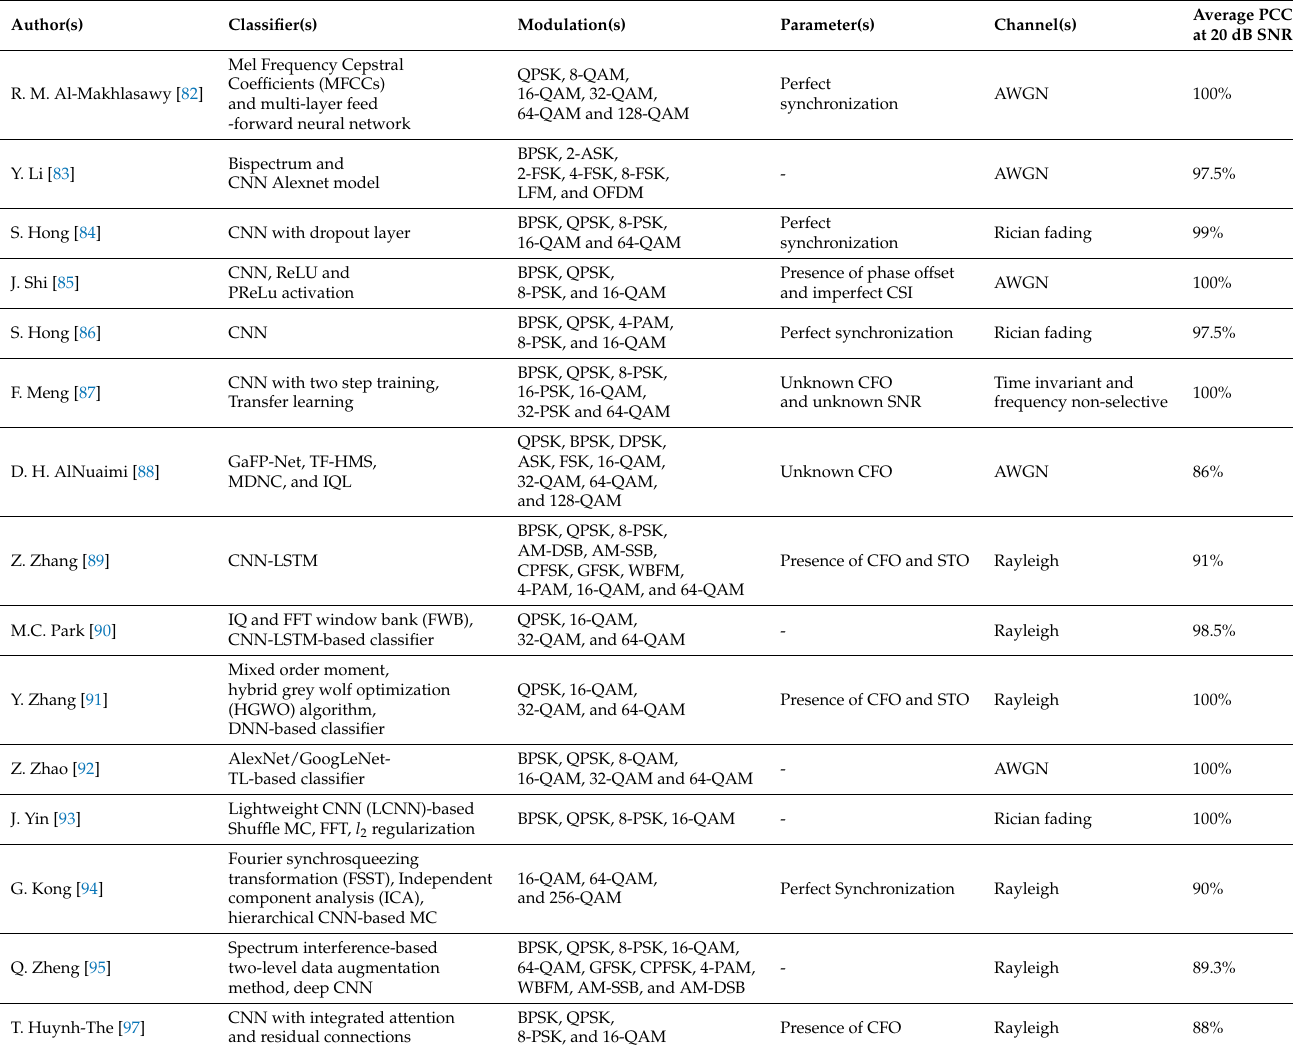
Table 6. Summary of DL-based classifiers for OFDM